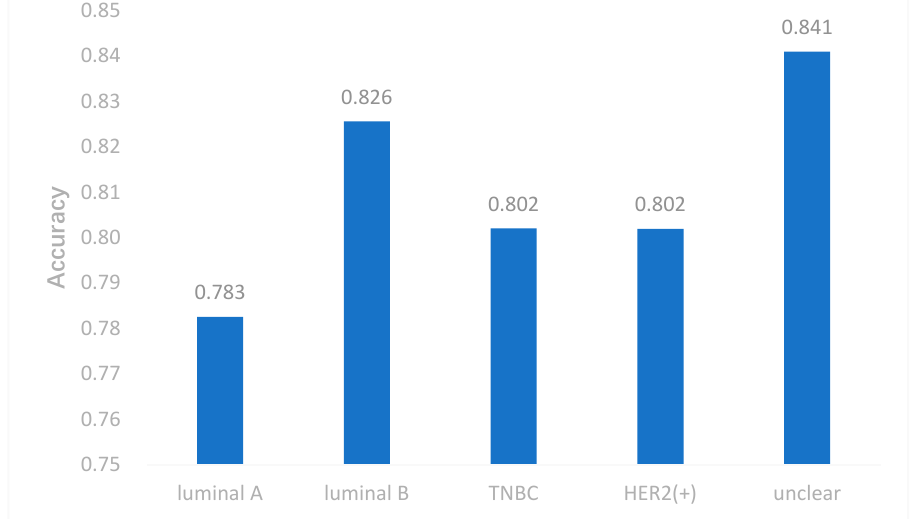
Figure 5. The accuracy of DeepMO when removing one subtype each time.